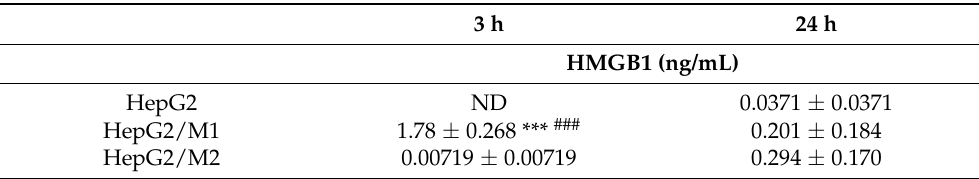
Table 1. HMGB1 concentrations in the medium of HepG2, HepG2/M1, and HepG2/M2 3 h or 24 h after DIC treatment (500 µ M).